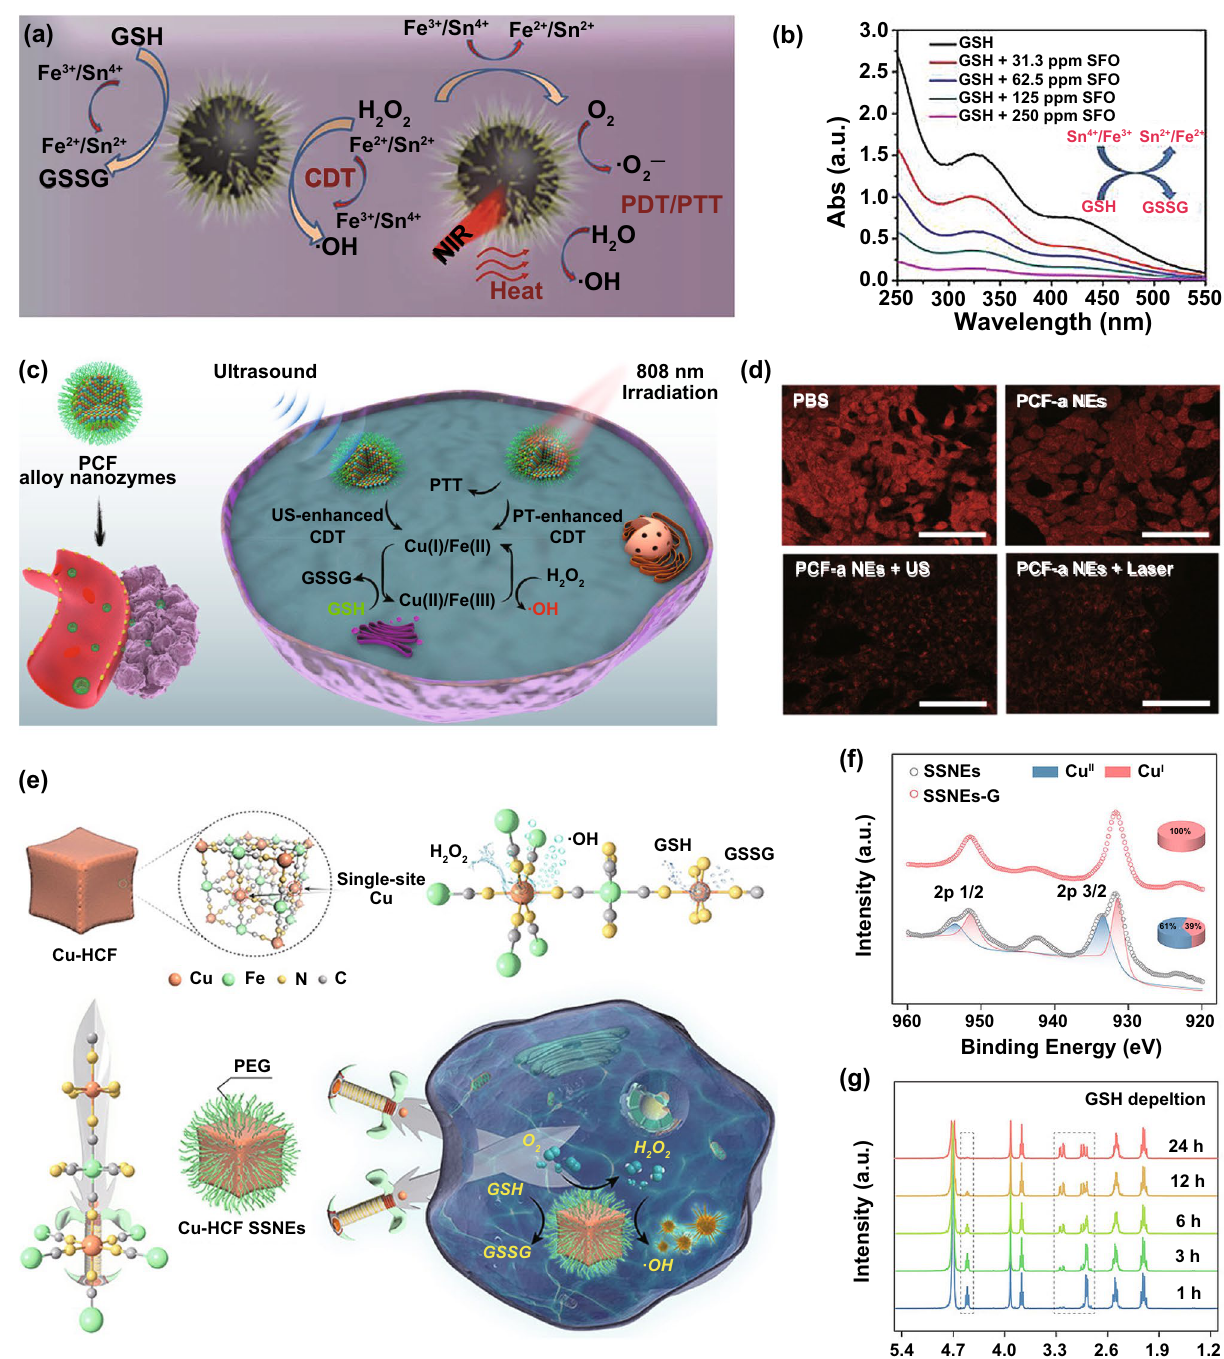
Fig. 13 a Schematic illustration of the synergistic therapy mechanism for SFO. b Concentration-dependent GSH depletion ability of SFO. Reproduced with permission from Ref. [115]. Copyright 2020, WILEY–VCH GmbH. c Schematic illustration of PCF-a nanozyme with POD- and GPx-like activities for dual-modal cancer therapy. d Intracellular GSH levels in cancer cells with different treatments. Reproduced with permission from Ref. [37]. Copyright 2021, American Chemical Society. e Schematic illustration of Cu-HCF single-site nanozymes (SSNEs) for tumor-specific cascade enzymatic therapy. f Cu 2p X-ray photoelectron spectroscopy results of SSNEs and SSNEs-G. “SSNEs-G” represents GSH-pretreated SSNEs. g 1 H nuclear magnetic resonance (NMR) spectra of GSH at different reaction times in the presence of SSNEs. Repro- duced with permission from Ref. [76]. Copyright 2020, WILEY–VCH